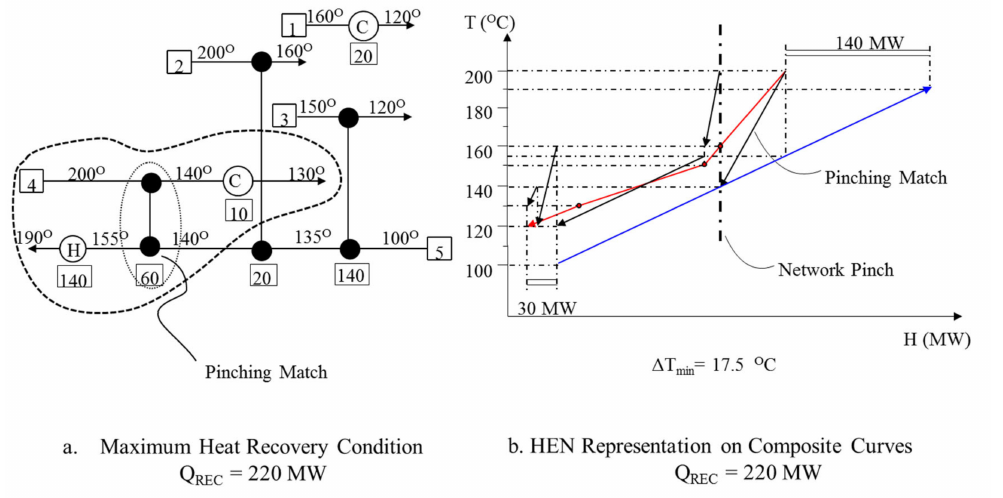
Figure 3. Network